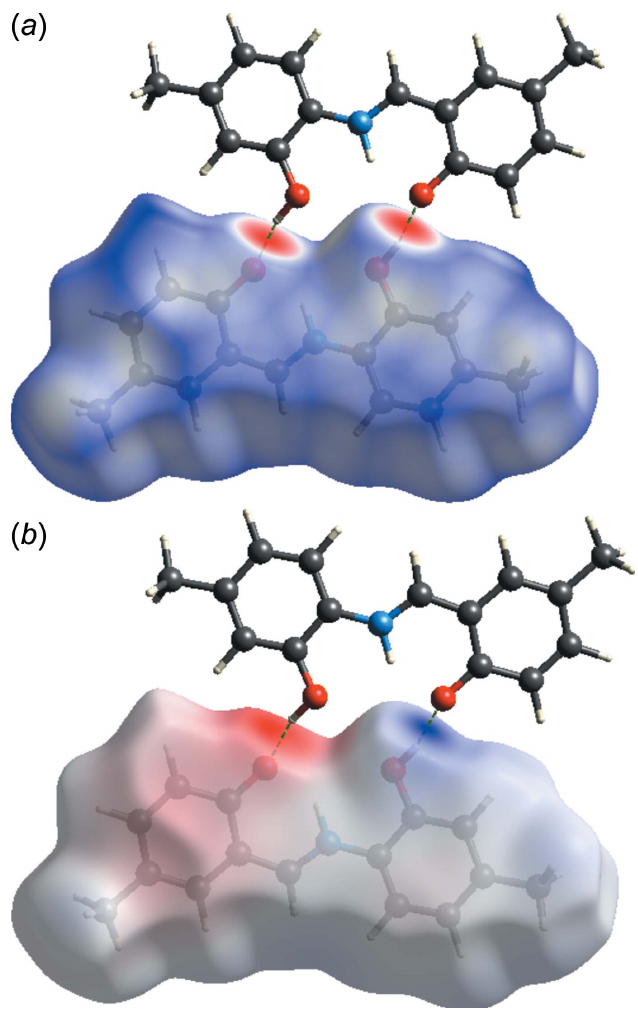
Figure 4 ( a ) The Hirshfeld surface mapped over d norm , and ( b ) the molecular electrostatic potential surface showing the O—H (cid:3)(cid:3)(cid:3) O interactions.